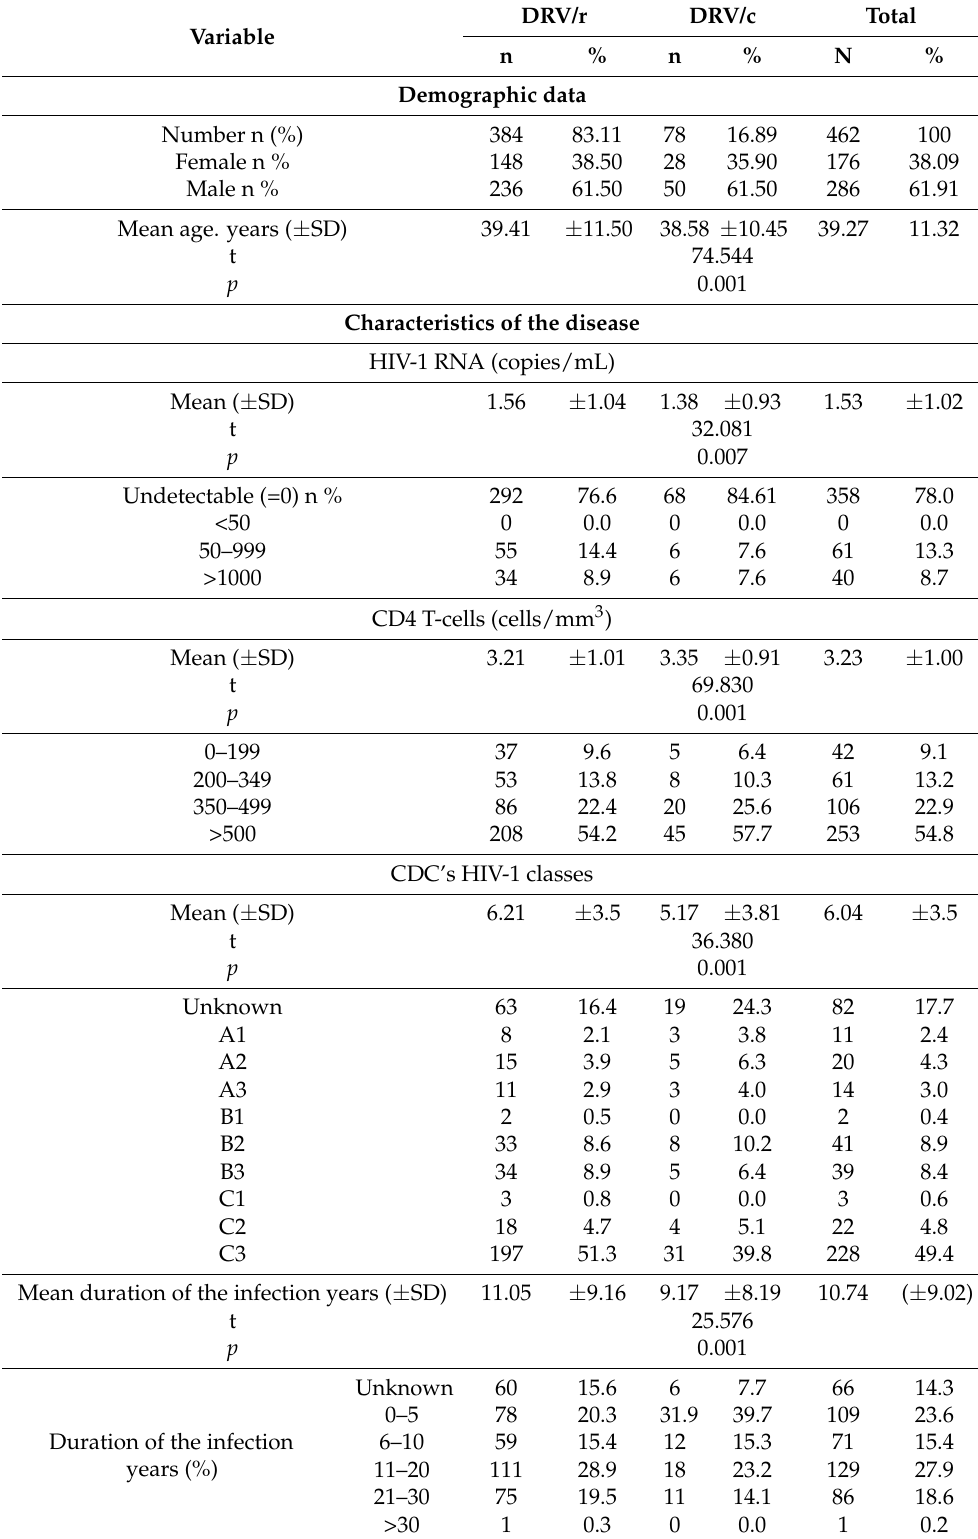
Table 1. Demographic and clinical